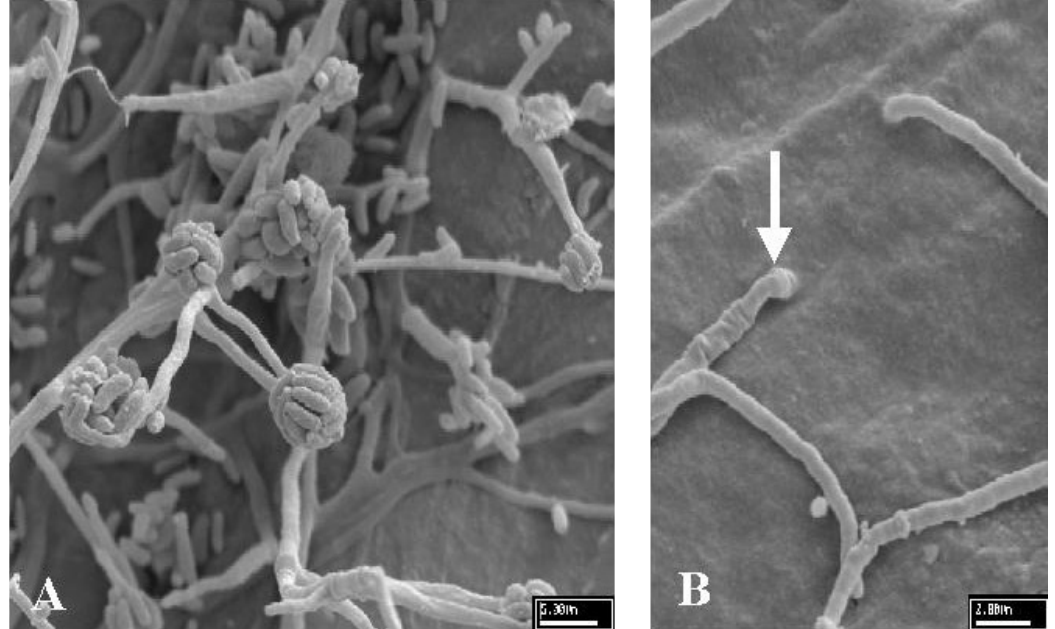
Fig. 1. SEM photomicrographs of Phaeoacremonium inflatipes on the root surface 48 h after inoculation showing (A) conidiophores and spores and (B) apparent hyphal penetration via appressoria (arrow).